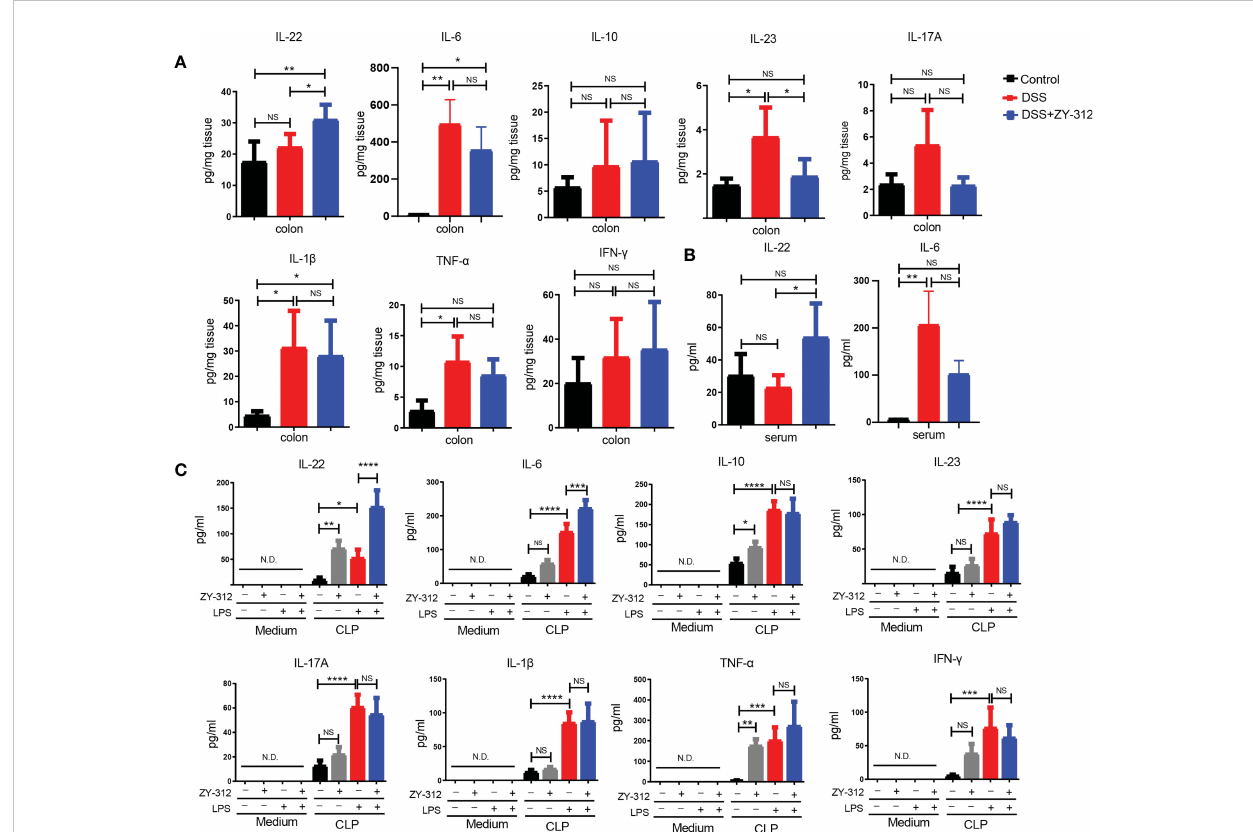
FIGURE 4 B.fragilis promoted IL-22 production, but not IL-1 b and TNF- a mediated classical proin fl ammatory pathway in DSS-induced colitis. (A) ELISA analysis of the in fl ammatory factors including IL-22, IL-6, IL-23, IL-1 b , TNF- a , IFN- g , IL-17A, and IL-10 from colon tissue in DSS-induced colitis. (B) ELISA analysis of IL-22, and IL-6 from serum in DSS-induced colitis. (C) ELISA analysis of IL-22, IL-6, IL-23, IL-1 b , TNF- a , IFN- g , IL-17A, and IL-10 in supernatant from co-culture model including B. fragilis strain ZY-312 and CLP after lipopolysaccharide (LPS,1ug/ml) stimulation for 12 hours in vitro . Data are presented as Mean ± SEM (A – C) . Statistical analysis was performed using one-way ANOVA. * p < 0.05,** p < 0.01, *** p < 0.005, **** p < 0.001.ND indicates undetectable. NS indicates no signi fi